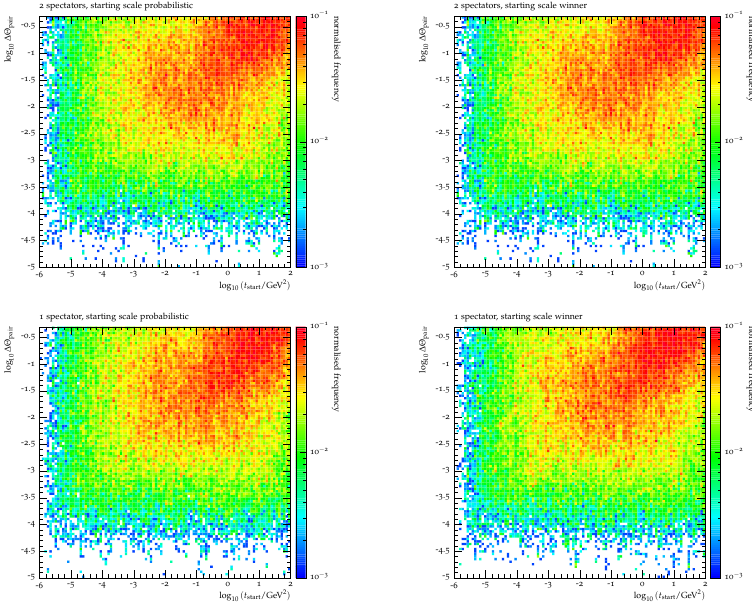
Figure 3 . The interdependence of the starting scale t start of a photon and the angular separation between the particles produced in its splitting, ∆Θ pair , in mixed ordering scheme with different choices of kinematic spectators of the photon splitting, both charged primary leptons (top row) or only the primary lepton the splitting photon was reconstructed to have been emitted from (bottom row), and the way in which the starting scale of the evolution is chosen, probabilistically (left column) or by always choosing the winning dipole (right